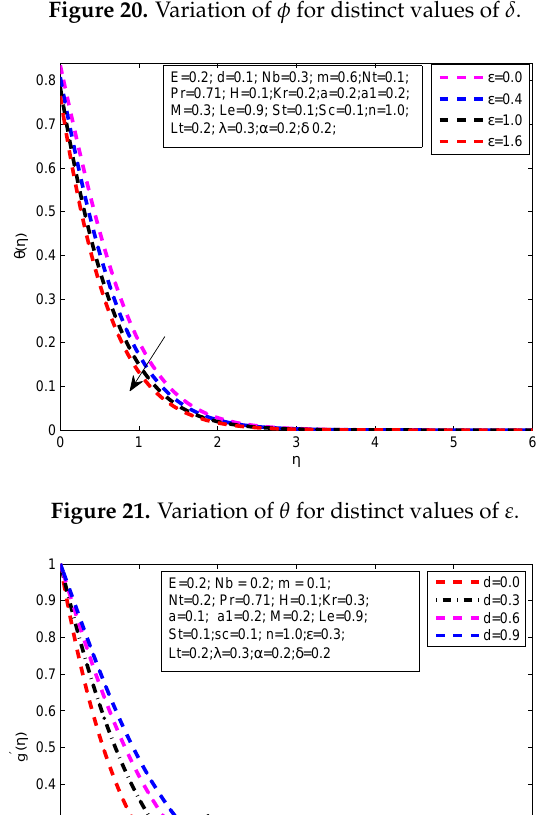
Figure 20. Variation of φ for distinct values of δ .